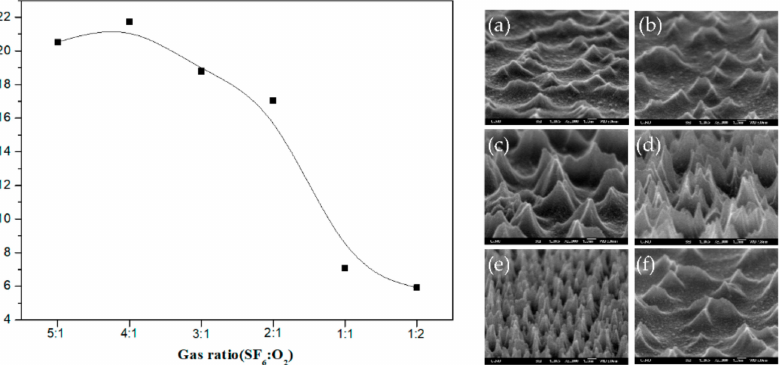
Figure 7. Reflectance and cross-section SEM images of wafer surfaces according to gas ratio for the RIE process: ( a ) SF 6 :O 2 = 5:1, ( b ) SF 6 :O 2 = 4:1, ( c ) SF 6 :O 2 = 3:1, ( d ) SF 6 :O 2 = 2:1, ( e ) SF 6 :O 2 = 1:1, and ( f ) SF 6 :O 2 = 1:2.